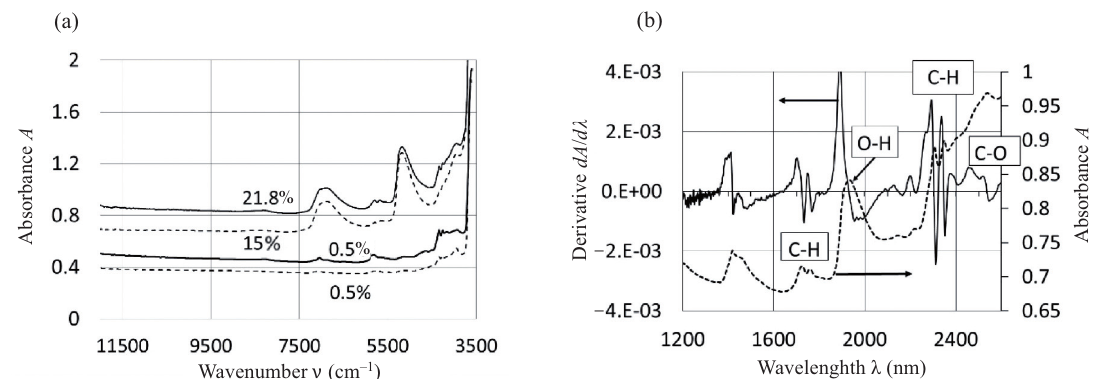
Fig. 2. (a) absorbance spectra of samples with drastically different values of caloricity and percentage of moisture content (indicated in figure); sample B ( Q d = 21.123 MJkg –1 , solid lines); sample BC ( Q d = 2.32 MJkg –1 , dashed lines). (b) absorbance and its derivative as a function of wavelength with the indication of characteristic absorbing bands; sample F1 ( Q d = 9.4 MJkg –1 , W